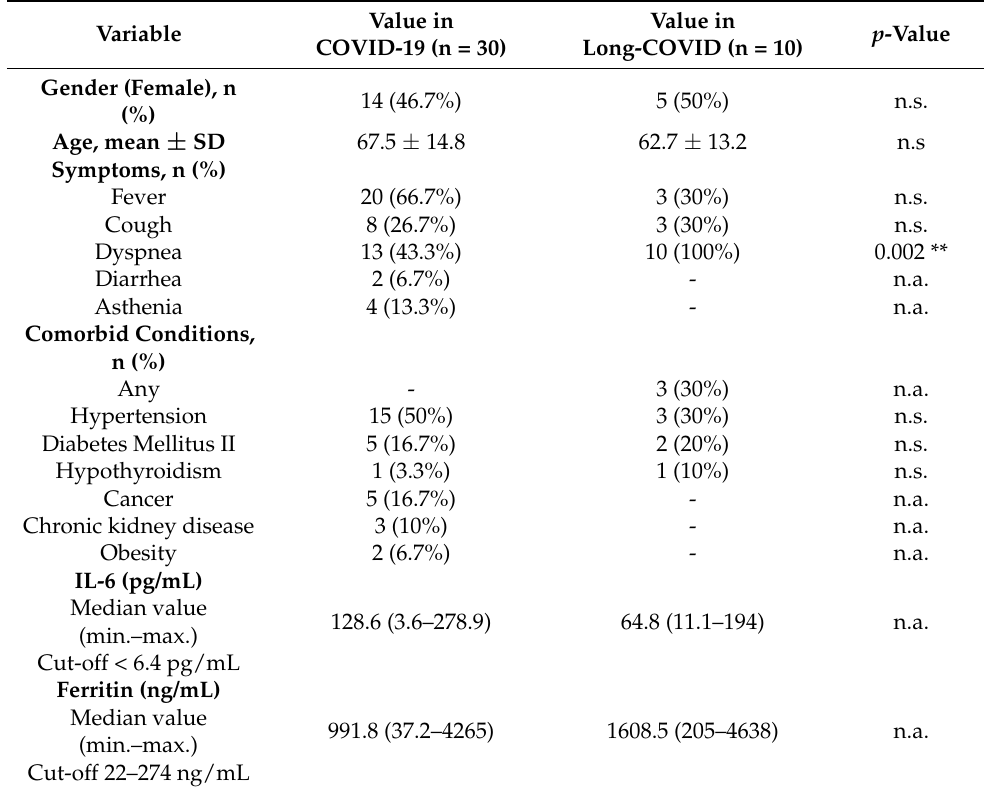
Table 1. COVID-19 (n = 30) and long-COVID (n = 10) patient